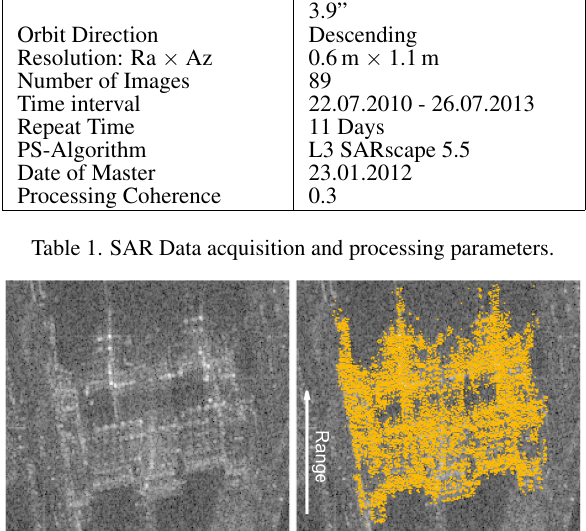
Figure 2. The Reichstag in SLC Image with PS-points (right). The SAR-typical imaging geometry: layover, foreshortening